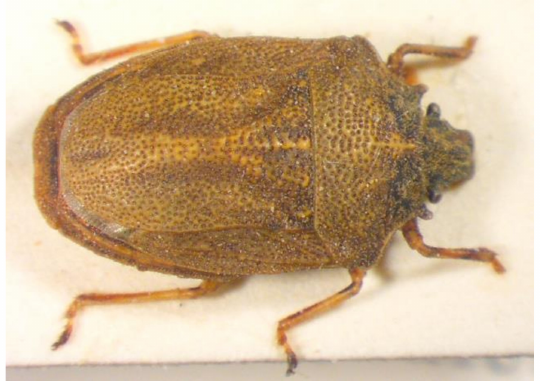
Figure 17. Podops (Podops) inunctus (Collector S. Drosopoulos, Kamariotissa, 5.VI.1982, posited in